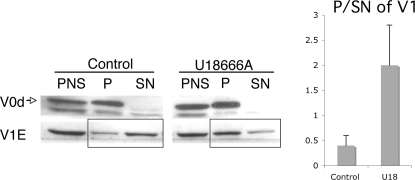
Increase of V1 association to membrane upon U18666A treatment.PNS was submitted to high speed spinning and pellet (P) and supernatant (SN) were loaded on a gel. Western blotting was revealed with V0d and V1E subunit antibody. Quantification reveals that upon U18666A treatment, V1E is 4-fold more associated with the membrane (pellet) than in control cells.